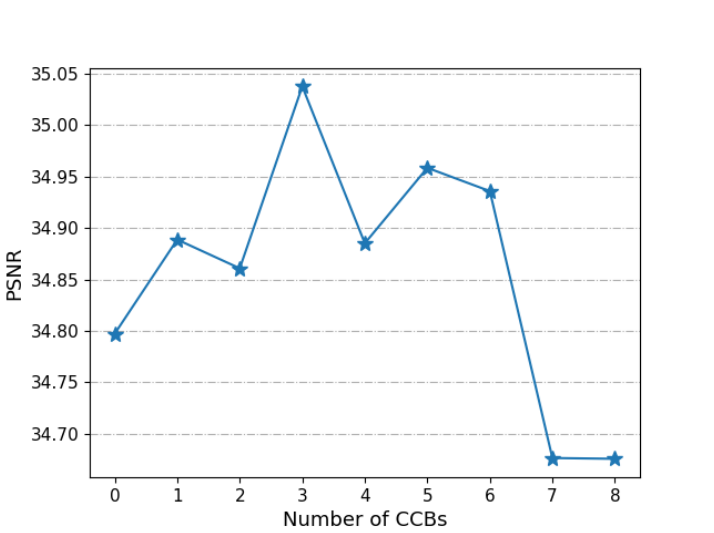
Figure 8. PSNR vs. Number of CCBs. Test on RICE1.